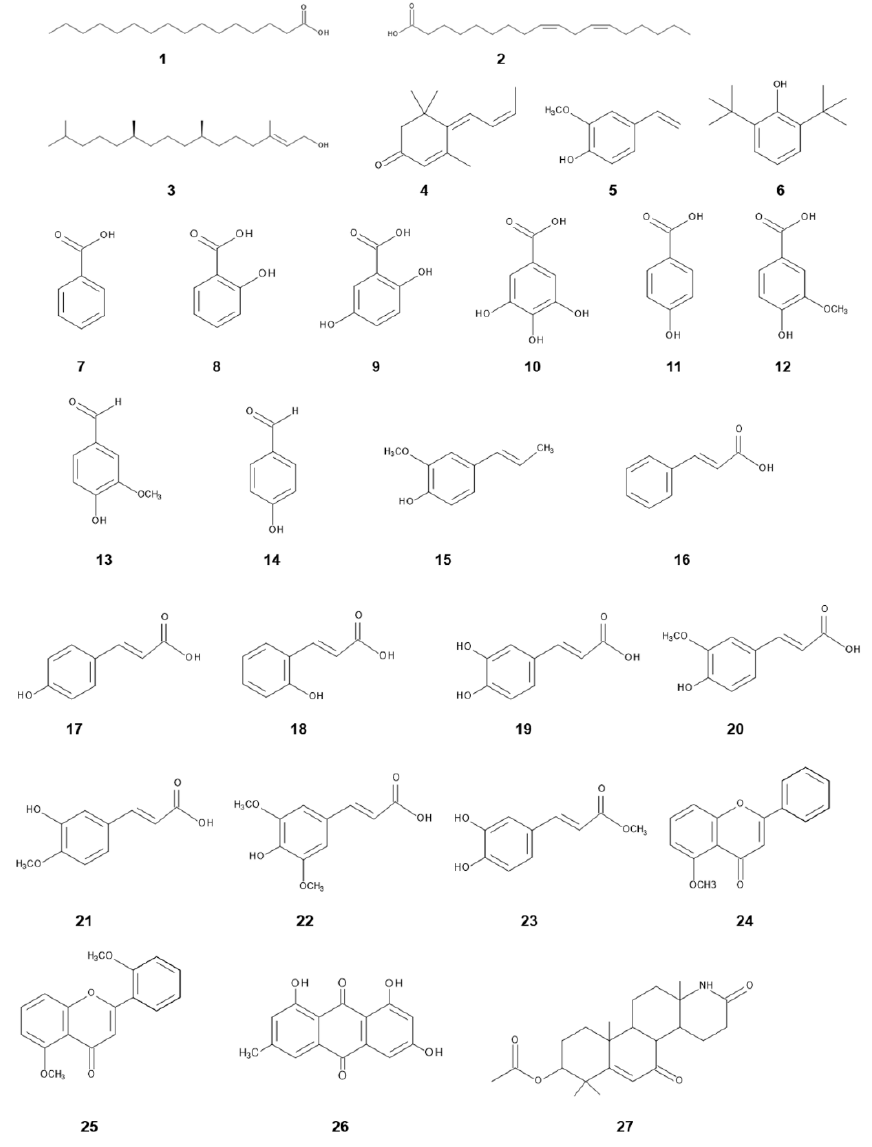
Figure 2. Allelochemicals identified in Imperata cylindrica. Compound numbers and names are listed in Table 2.